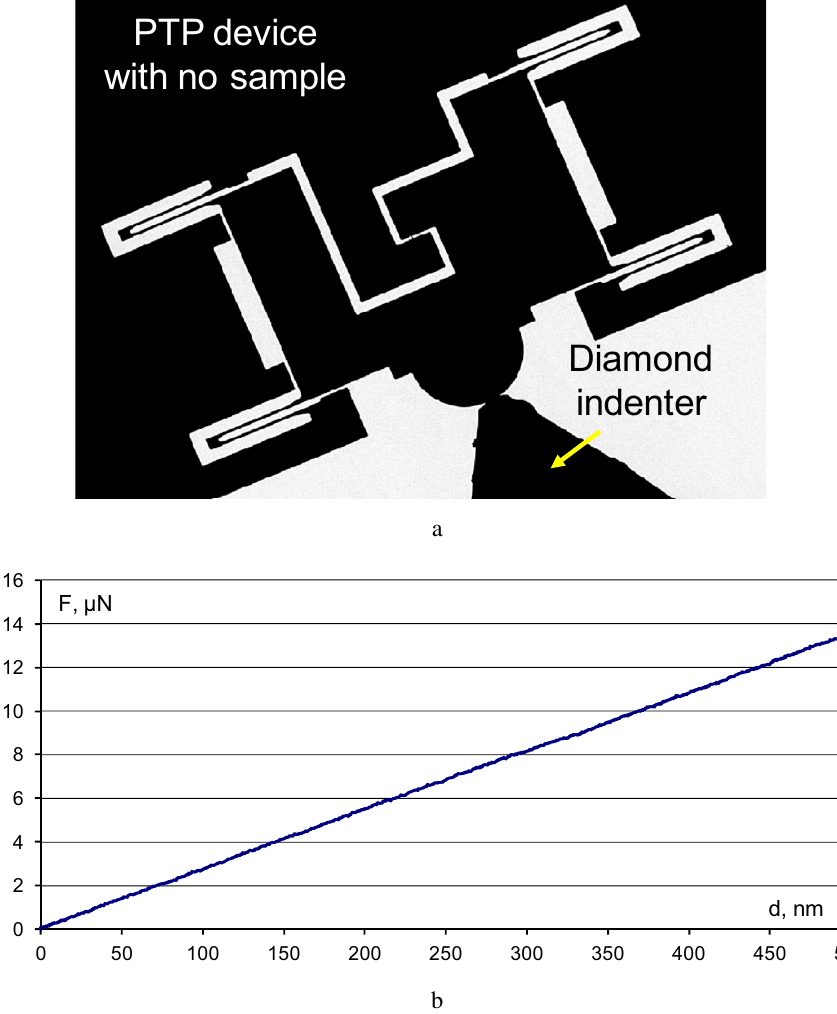
Figure 3. The PTP device without test sample and the indenter brought close to it ( a ) and the “zeo” curve displaying the stiffness of the PTP device ( b